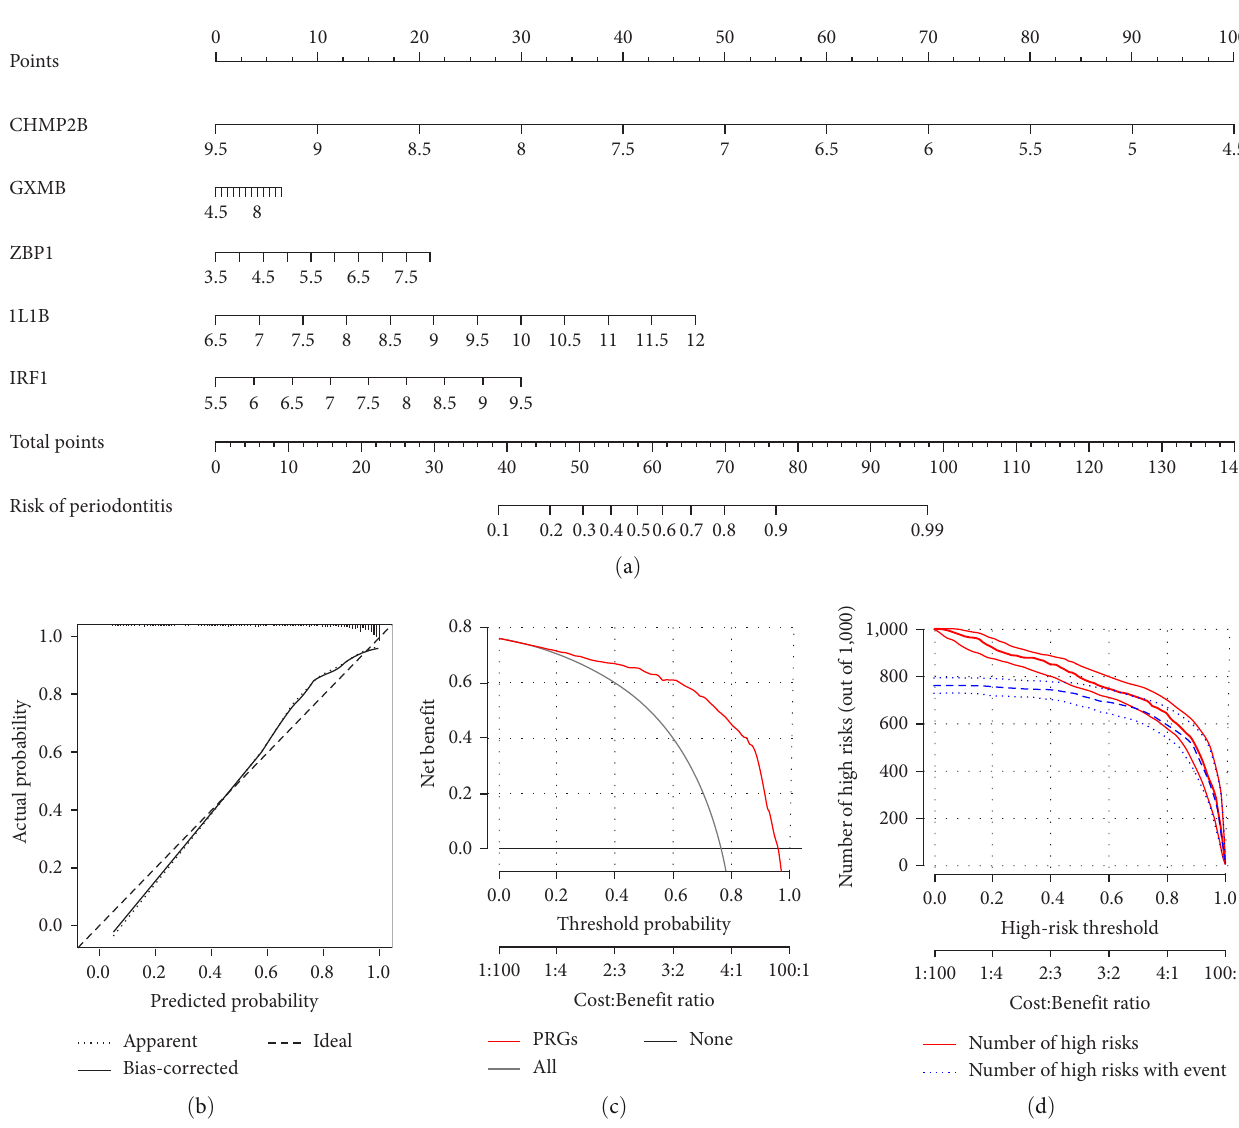
F IGURE 5: Building of the PRG-based predictive model. (a) The predictive model was constructed on the basis of the fi ve hub PRGs. (b) The calibration curve demonstrated the predictive ability of the model. (c) Patients of periodontitis may derive bene fi ts from the model. (d) The clinical impact curve assessed the clinical impact of the model. PRG, pyroptosis-related